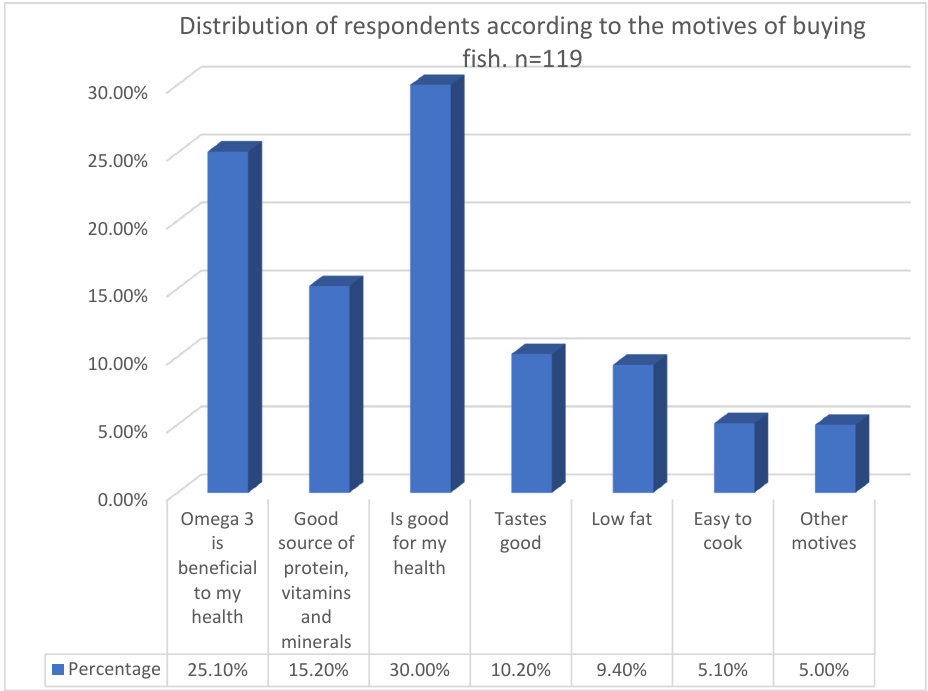
Figure 4. Distribution of respondents according to the reason of buying fish .